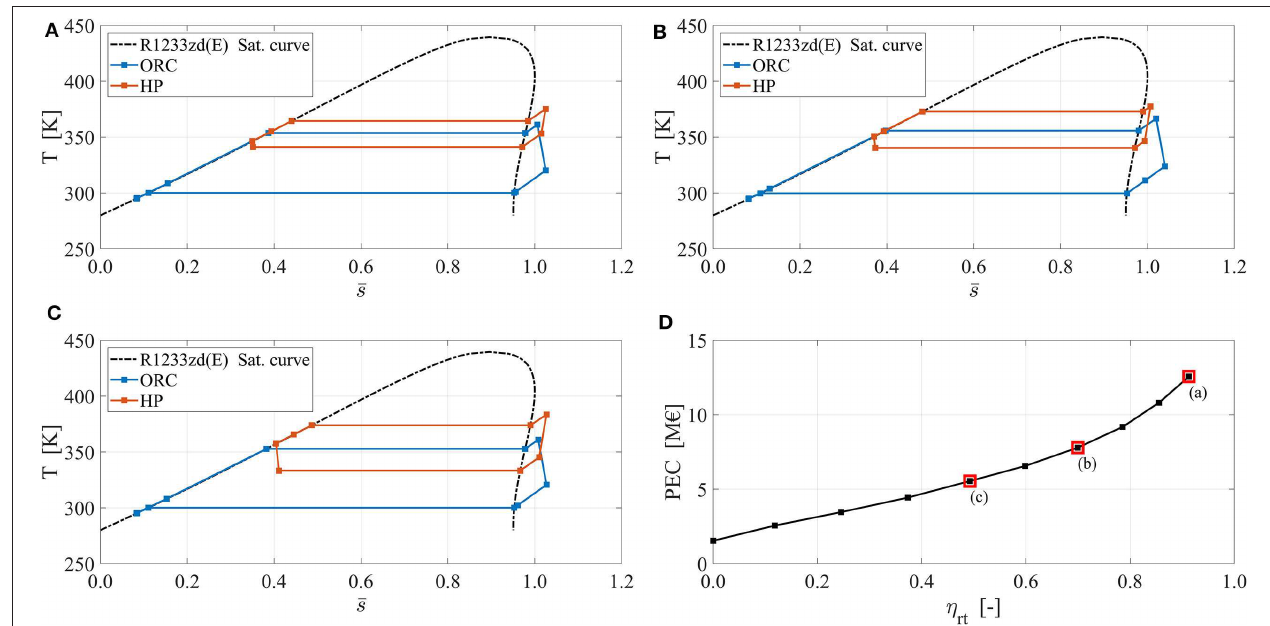
FIGURE 3 | HT-VCHP and ORC thermodynamic cycle arrangements on the temperature–entropy plane. The entropy is normalized as it follows: ¯ s = ( s − s min )/( s max − s min ) , where s min and s max are the minimum and the maximum of the entropy achieved over the whole saturation line for T > 280K. Results are reported for T in , src = 80 ◦ C, τ ch = 6h, and ˙ W hp . = 2,000 kW el . (A) High efficiency configuration. (B) Medium efficiency configuration. (C) Low efficiency configuration. (D) Position of configurations (A–C) over the Pareto